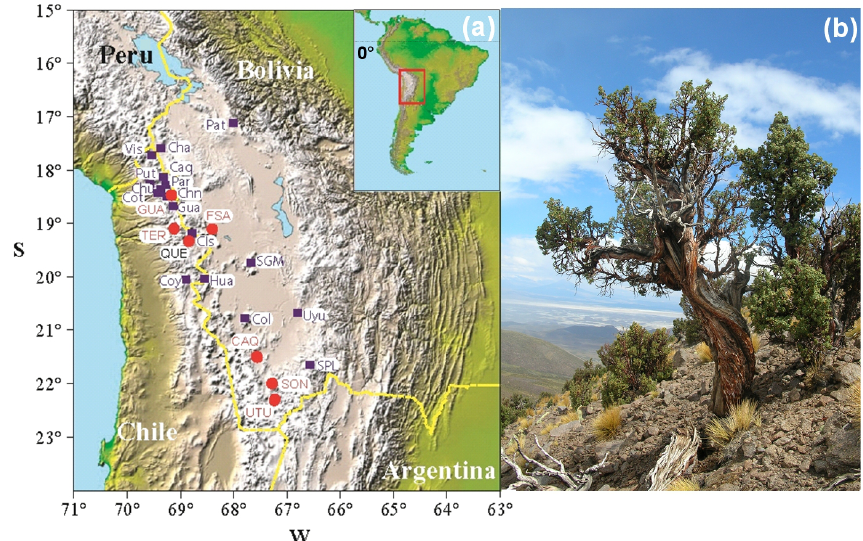
Fig. 1. Location of tree-ring sites (red dots) and precipitation stations (blue squares) in the Altiplano, Central Andes. See Tables 1 and 2 for code identifications (a) . A 500yr old Polylepis tarapacana ( Que˜noa ) individual growing on the slope of the Tata Sabaya volcano in Bolivia at 4750ma.s.l. In the background, the Coipasa salt lake on the Bolivian-Chilean border (b)